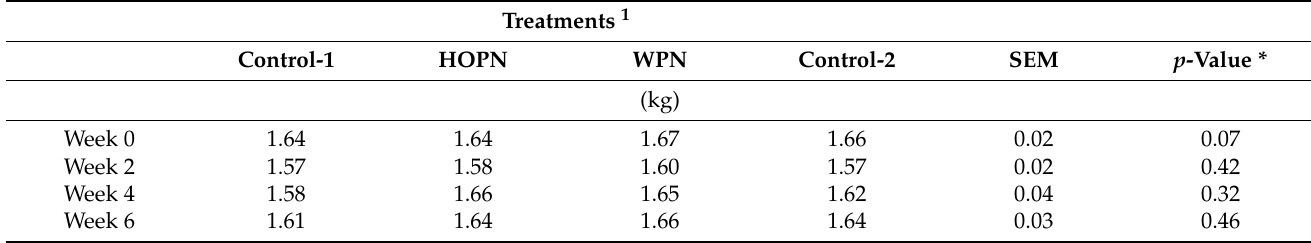
Table 3. Body weights of hens fed a control or peanut-containing diet.